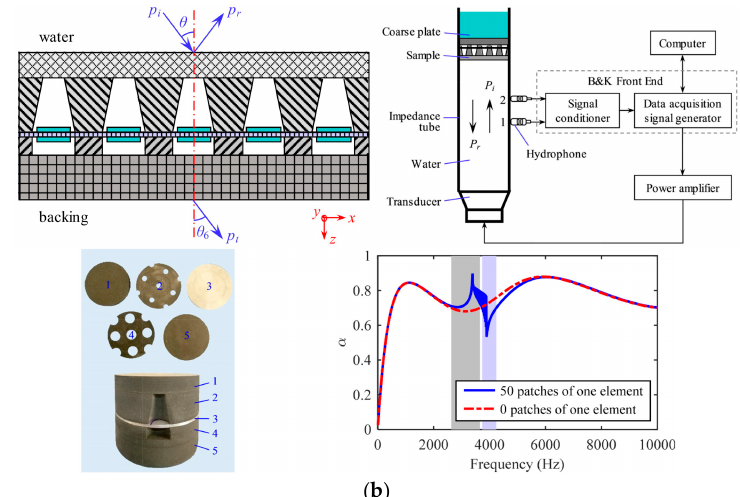
Figure 8. Design on semi-active acoustic coatings. ( a ) Mason equivalent circuit of two piezoelectric layers, experimental sample and finite element model with polyurethane waterproof layer [41]. ( b ) Schematic diagram of the composite coating, test schematic of a hydroacoustic impedance tube, test sample, and comparison between theoretical predictions of the coating [42].